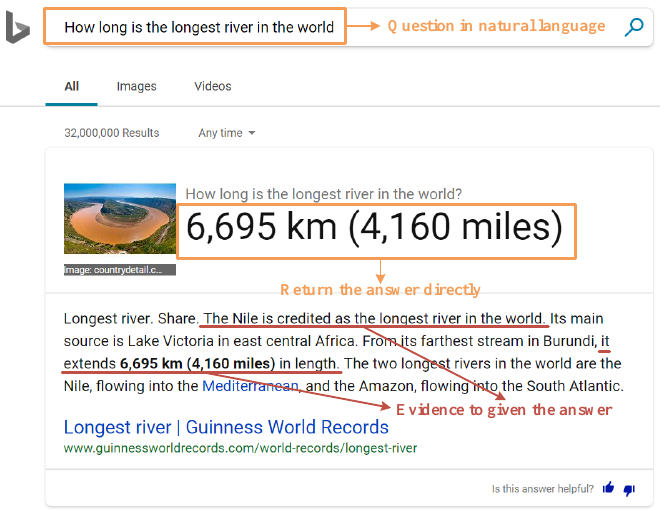
Figure 1. An example of search engine Bing (https://cn.bing.com/) with machine reading comprehension (MRC)